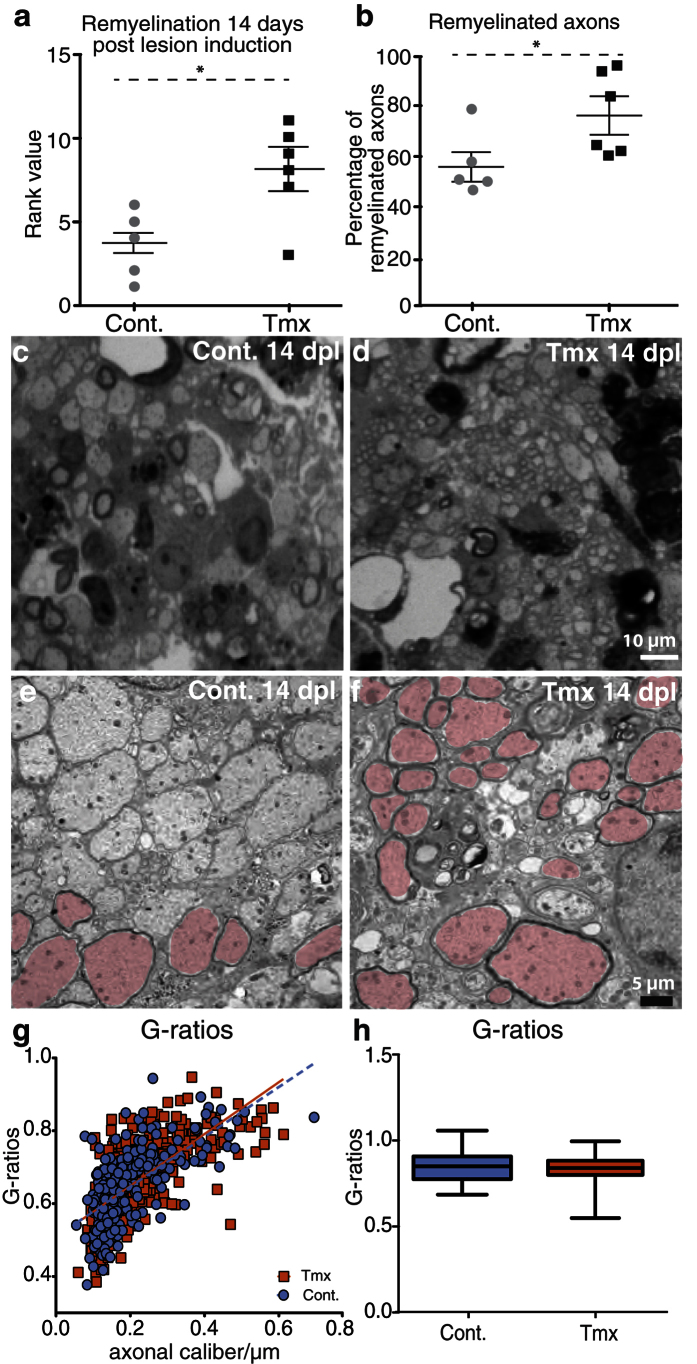
Tamoxifen treatment accelerates CNS remyelination.(a) Rank analysis (scatter plot) of remyelination in CCP lesions at 14 pli assessed on toluidine-blue-stained semithin sections. Higher rank scores indicate a greater extent of remyelination (n ≥ 5); Mann-Whitney U test: p < 0.05. (b) Enhanced remyelination was confirmed by manual counts of remyelinated and demyelinated axons on digitized sections (n ≥ 5). Mann-Whitney U test: p < 0.05. (c,d) Representative toluidine blue-stained semithin sections (100x) of vehicle (‘Cont.’) and tamoxifen-treated animals. (e,f) Representative electron micrographs of control and tamoxifen-treated animals (remyelinated axons pseudo-colored). (g,h) Scatter plot and box plot of G-ratios demonstrating comparable relative thickness of newly formed myelin sheaths in control and tamoxifen-treated lesions. Student’s t-test: p > 0.05. Error bars: SEM. Scale bar: in c, d = 10 μm; in e, f = 5 μm.